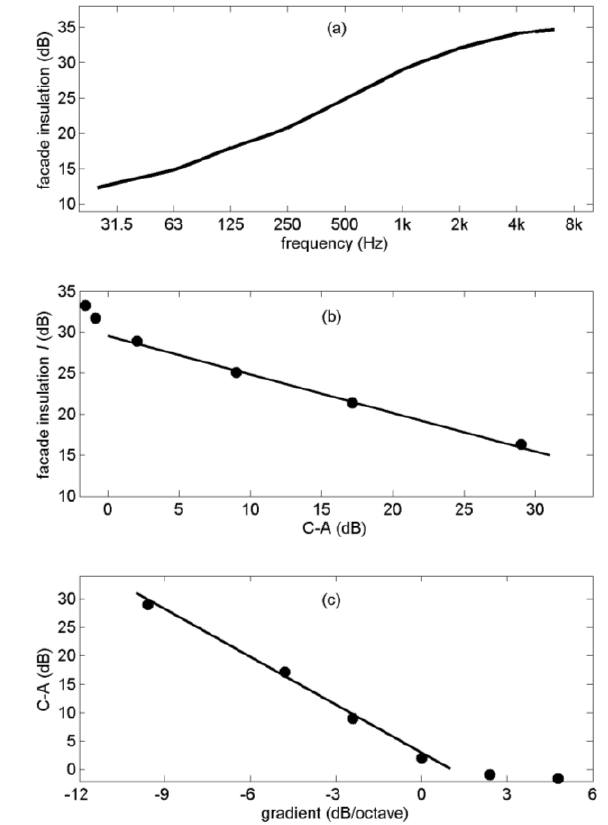
Figure 9. Spectrum of façade insulation used in this study [16] (a) , A-weighted façade insulation I as a function of C–A (b) , and value of C–A as a function of the gradient of the linear spectrum (c) , for the six spectra shown in Figure 8a. The straight lines are guides to the